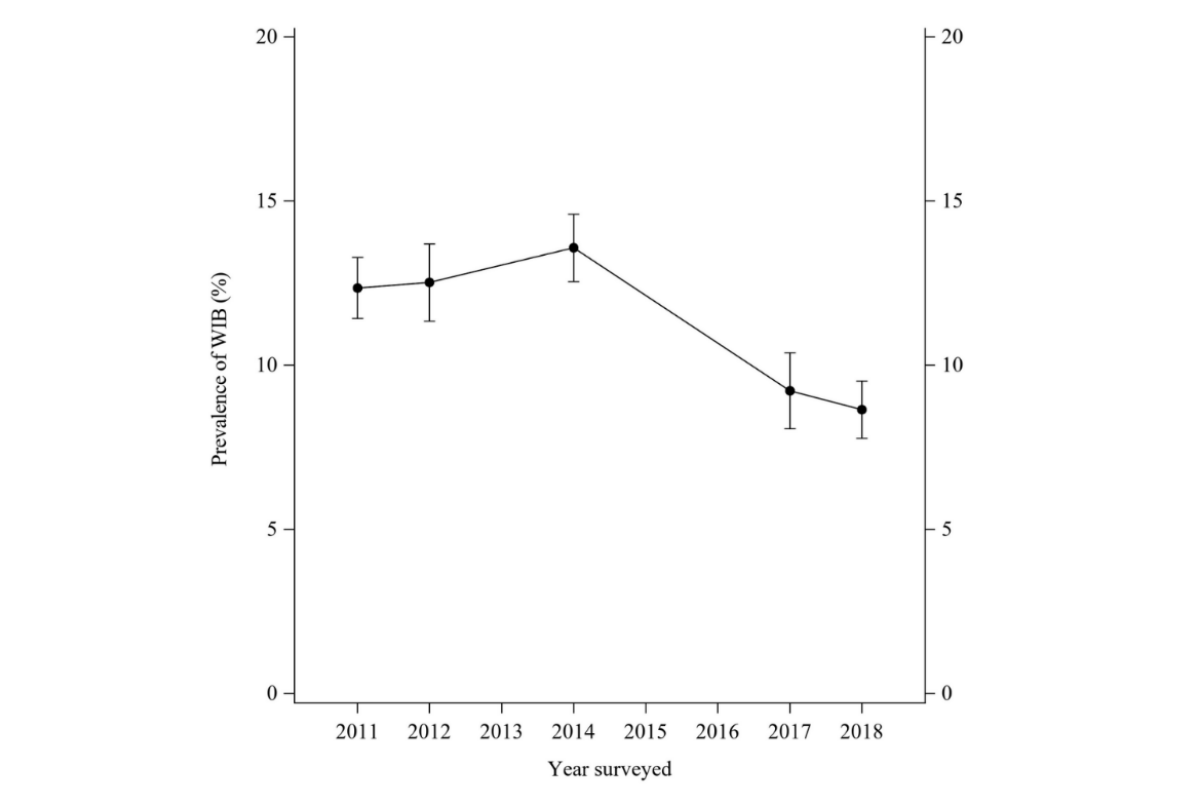
Figure 2. Unadjusted prevalence trend of withholding information behavior between 2011 and 2018 based on the Health Information National Trends Survey.